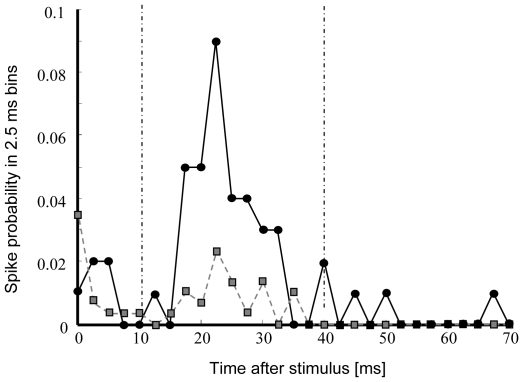
Effect of training protocol on the post stimulus time histogram (responsiveness) of the evaluation electrode.Dashed (gray, ▪) line shows the probability to record an action potential at a selected evaluation electrode during the first 10 stimuli of the training protocol. The time interval to determine the ‘responsiveness’ (the fraction of stimuli that yielded at least one action potential in this interval) was set at 10–40 ms (dash-dotted lines), such that the summed probability before training was about 0.1. Solid (black, •) line: same probability during the last 10 stimuli of the training protocol.